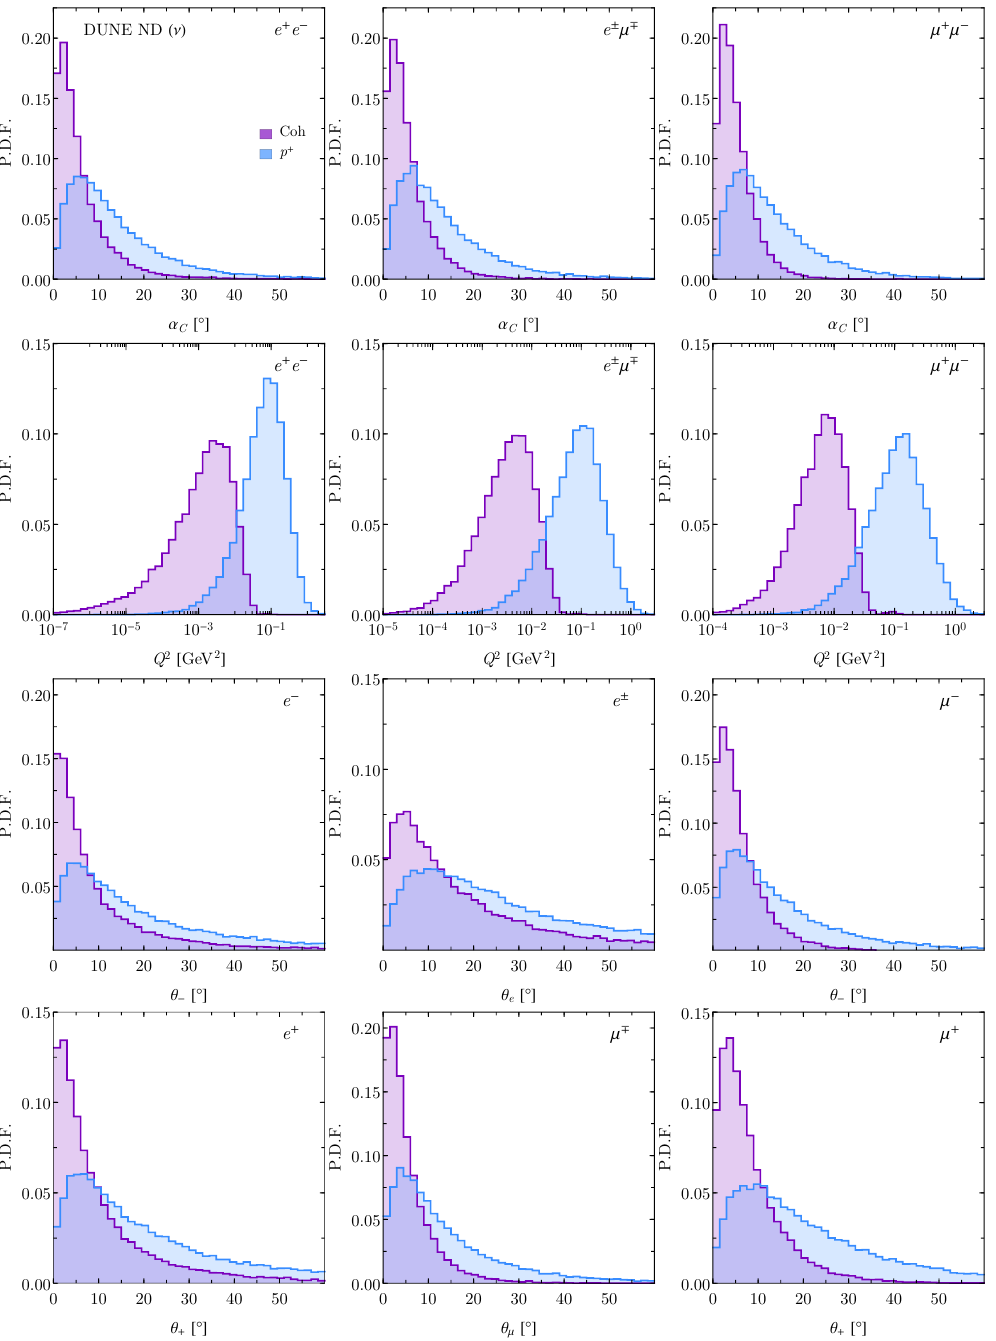
Figure 11 . Flux convolved neutrino trident production distributions for DUNE ND in neutrino mode in additional variables. In purple we show the coherent contribution in 40 Ar and in blue the di(cid:11)ractive contribution from protons as targets only (including Pauli blocking). The coherent and di(cid:11)ractive distributions are normalized independently.